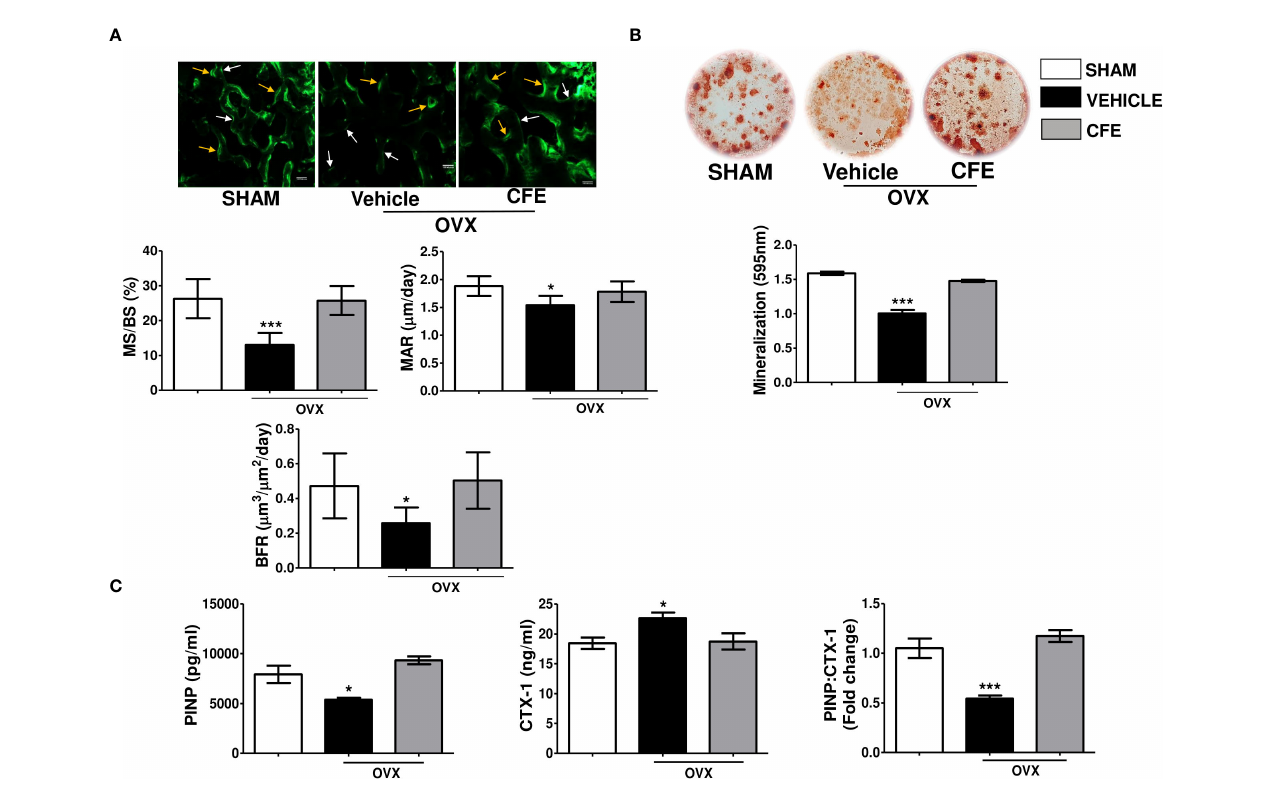
FIGURE 4 CFE has an osteoanabolic effect in osteopenic rats. (A) Upper panel showing representative images (scale bar, 100 µm) of single and double calcein labeled bone surfaces at tibia metaphysis; white arrows- single label and yellow arrows- double label surfaces; and the lower panel showing the histomorphometry parameters in the indicated groups. (B) Ex vivo mineralization assay was performed in bone marrow stromal cells obtained from the indicated groups. (C) Serum procollagen type I N-propeptide (PINP), cross-linked C-telopeptide of type I collagen (CTX1) levels and their ratio were determined by ELISA from the serum of rats with indicated treatments. For ELISA, serum samples of n = 6 rats from each group were taken. For ex vivo mineralization femurs and for histomorphometry tibia sections of n = 3 rats from each group were used. All data are expressed as mean ± SEM; *p <0.05, and ***p<0.001 vs.